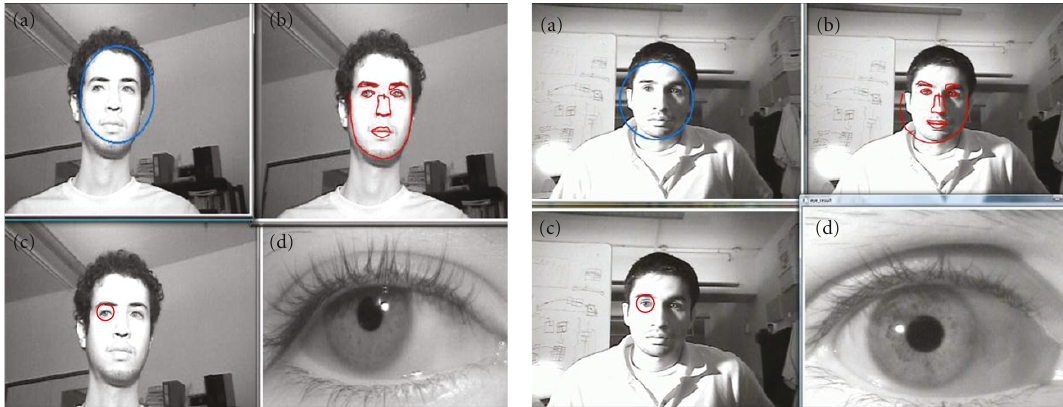
Figure 19: Face detection, eye detection, and iris acquisition shown for two users of the system. (a) shows the face detector. Once the face is determined to be stationary, the ASM is fitted and this is depicted in (b). (c) shows the position of the right eye read o ff from the ASM and finally (d) is the image of the eye and iris pattern acquired after the lens zooms into the location indicated in